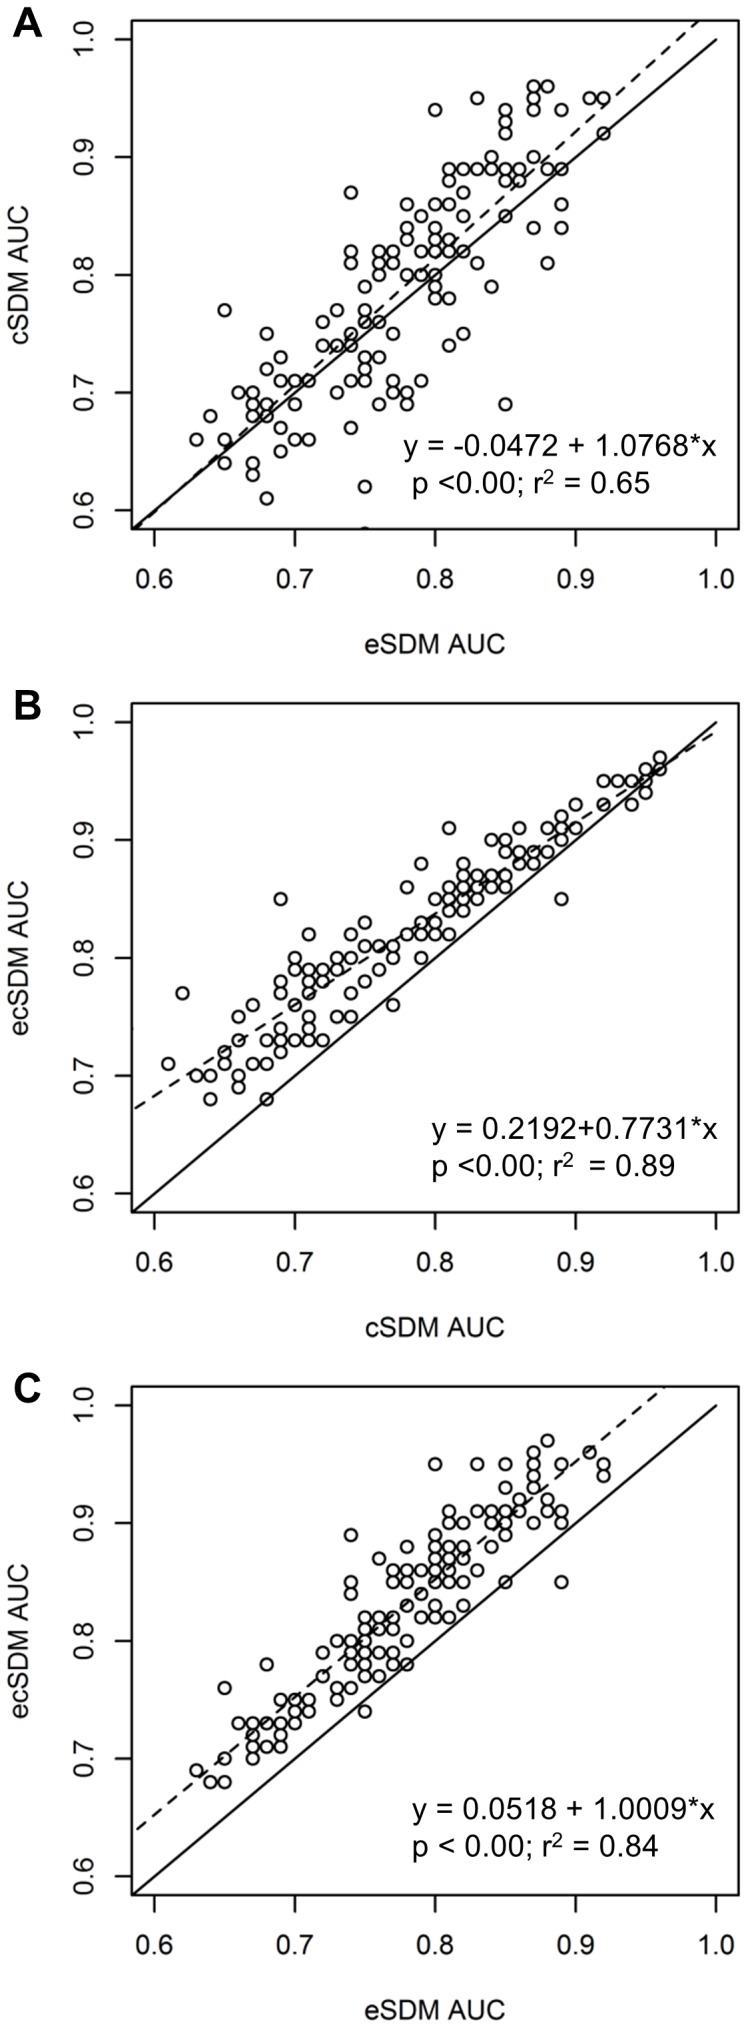
Comparisons of predictive accuracy of different abiotic model types through scatterplots and regressions.Average area under the curve of the receiver operator characteristic (AUC) for each species (mean of the 10 x cross-validation models of each statistical model type); solid lines have a slope of one with no intercept; dashed lines are the linear regression produced from either A) the AUC of the climate species distribution models (SDM) vs. AUC of the edaphic SDM; B) the AUC of the edaphic-climate SDM vs. the AUC of the climate SDM; or C) the AUC of the edaphic-climate SDM vs. the AUC of the edaphic SDM. Panel A: there is a small improvement to model fit if models are constructed from climate vs. edaphic predictors; panel B: improvement is greatest for models with lower predictive accuracy; panel C: improvement is consistent across strong and weak models, and is greater than that from adding edaphic predictors to climate models.